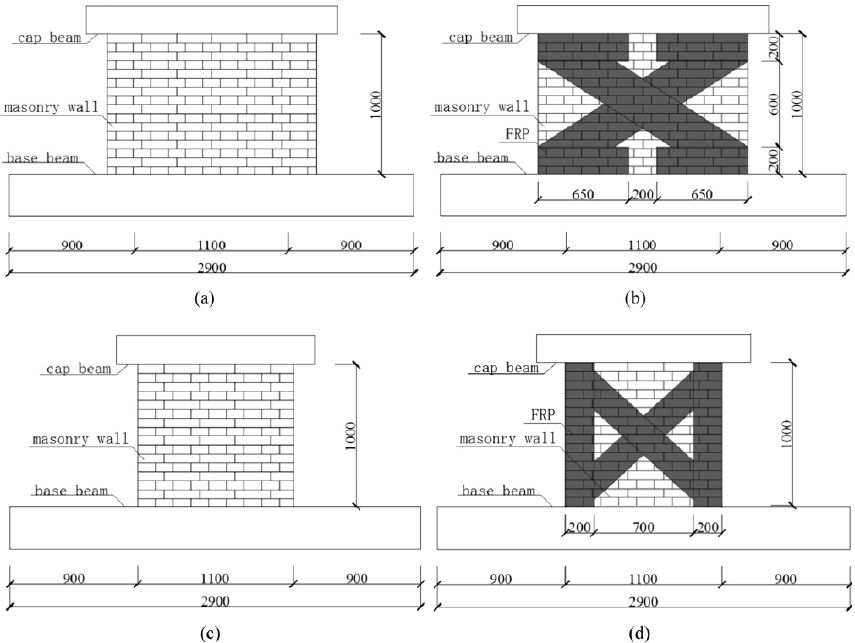
Figure 5. Configurations of specimens [59]: ( a ) W1; ( b ) BW1-1; ( c ) W2; ( d ) BW1-1. Reproduced with permission from Zhang, S., Yang, D., Sheng, Y., Garrity, S.W. and Xu, L. Numerical modelling of FRP-reinforced masonry walls under in-plane seismic loading; published by Elsevier, Construction and Building Materials, 2017.